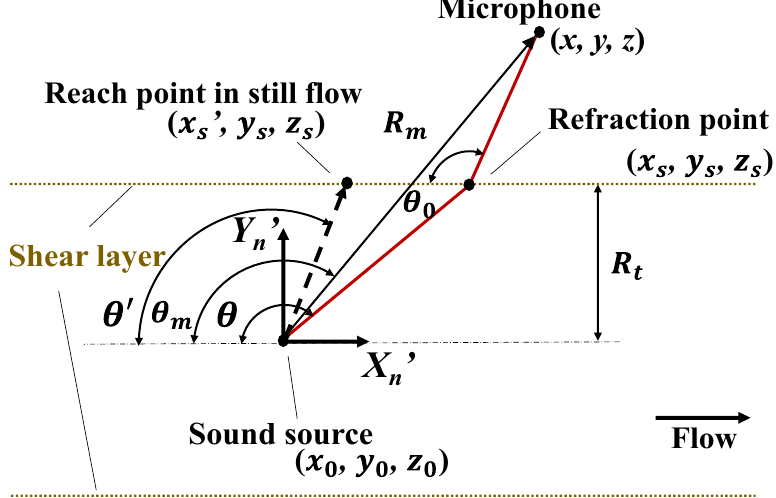
Figure 2. Schematic image of acoustic